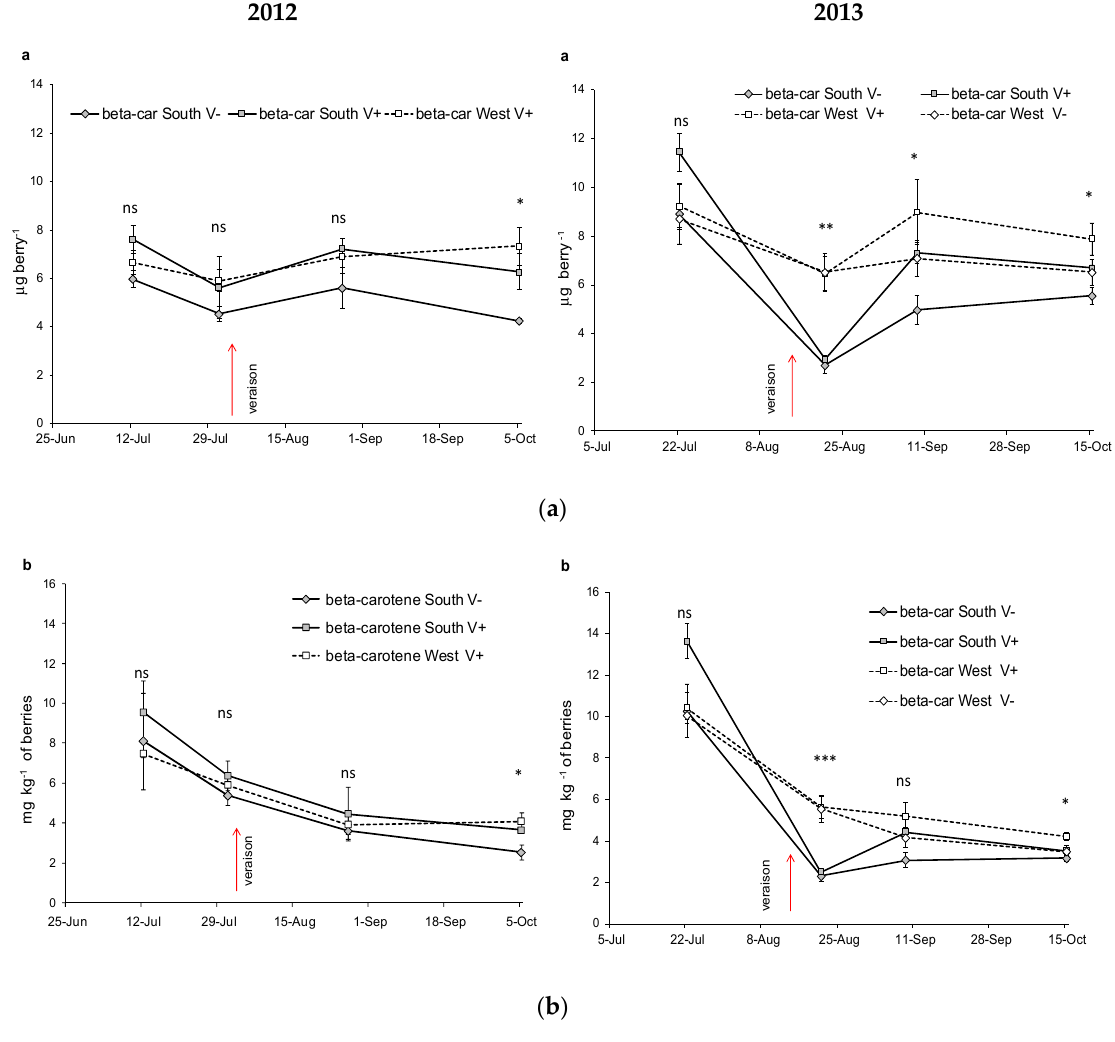
Figure 3. Seasonal changes of β -carotene as µ g berry − 1 ( a ) and mg kg − 1 of berries ( b ) in Nebbiolo grapes in 2012 (on the left) and 2013 (on the right), as a function of vine vigor and vineyard aspect. Averages ± standard error (n = 3). * p < 0.05, ** p < 0.01 *** p < 0.001 indicate the significance of differences among treatments.